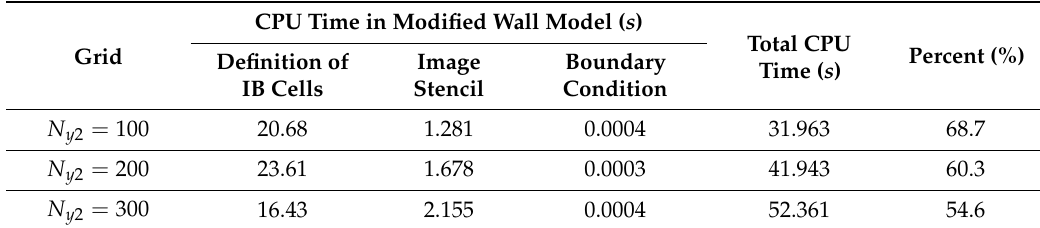
Table 1. Modified wall model performances on a single-core